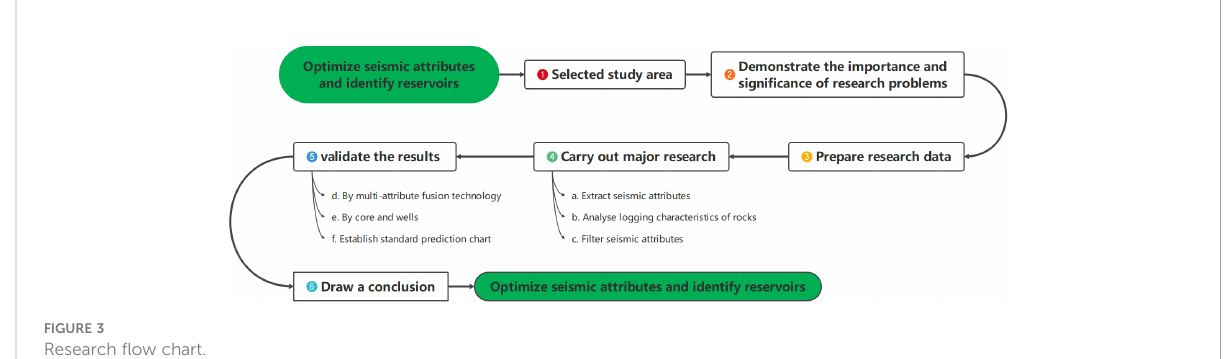
FIGURE 3 Research fl ow chart.